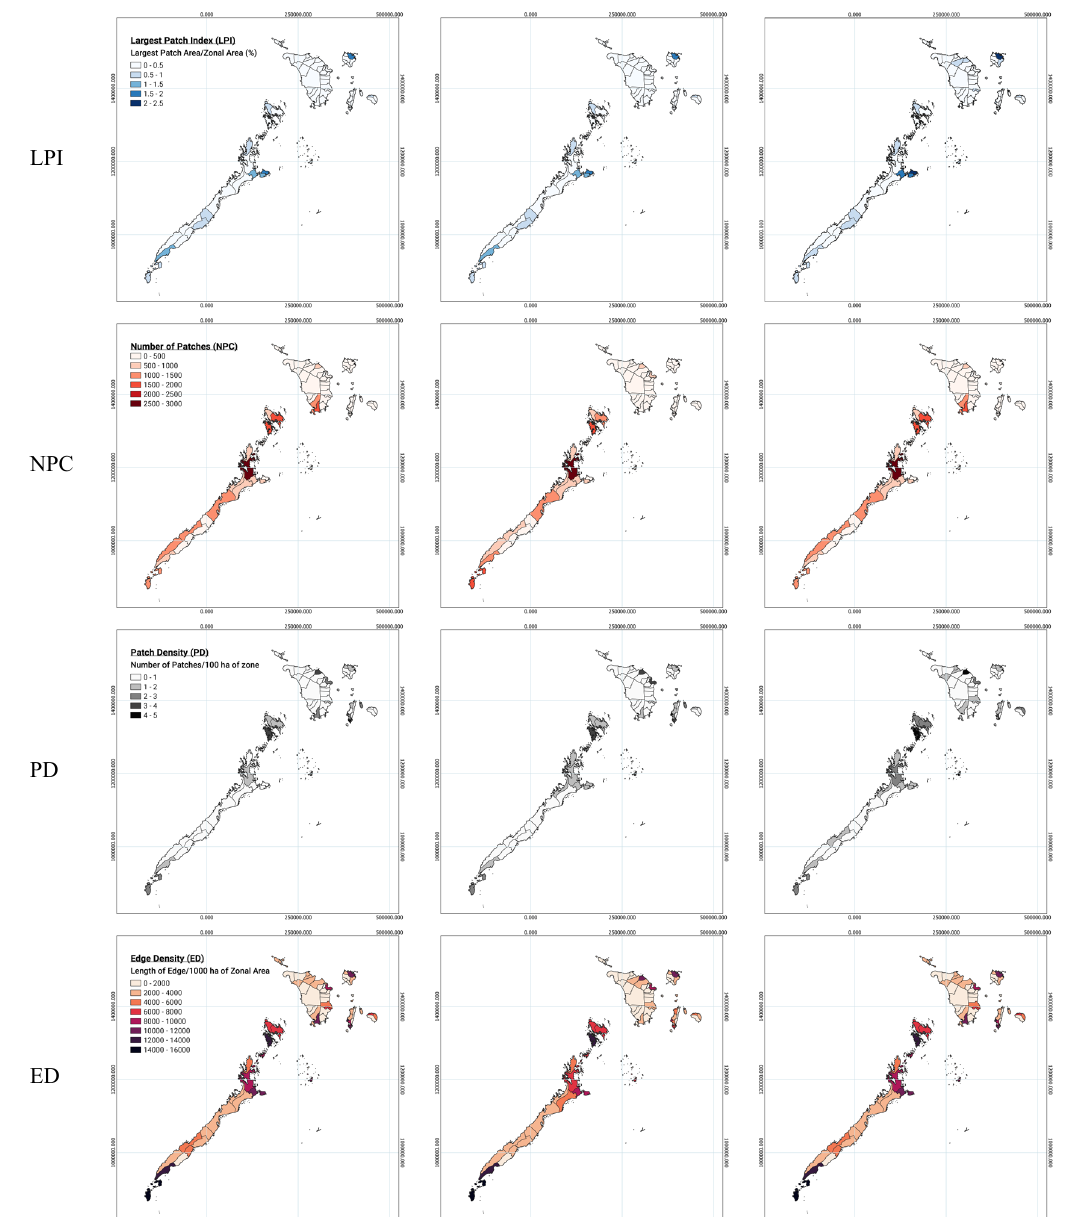
Table 12. Decadal City/Town-Level Landscape Metric Maps of Region IV-B. PZ = Percentage of Zone. LPI = Largest Patch Index. NP = Number of Patches. PD = Patch Density. ED = Edge Density Region